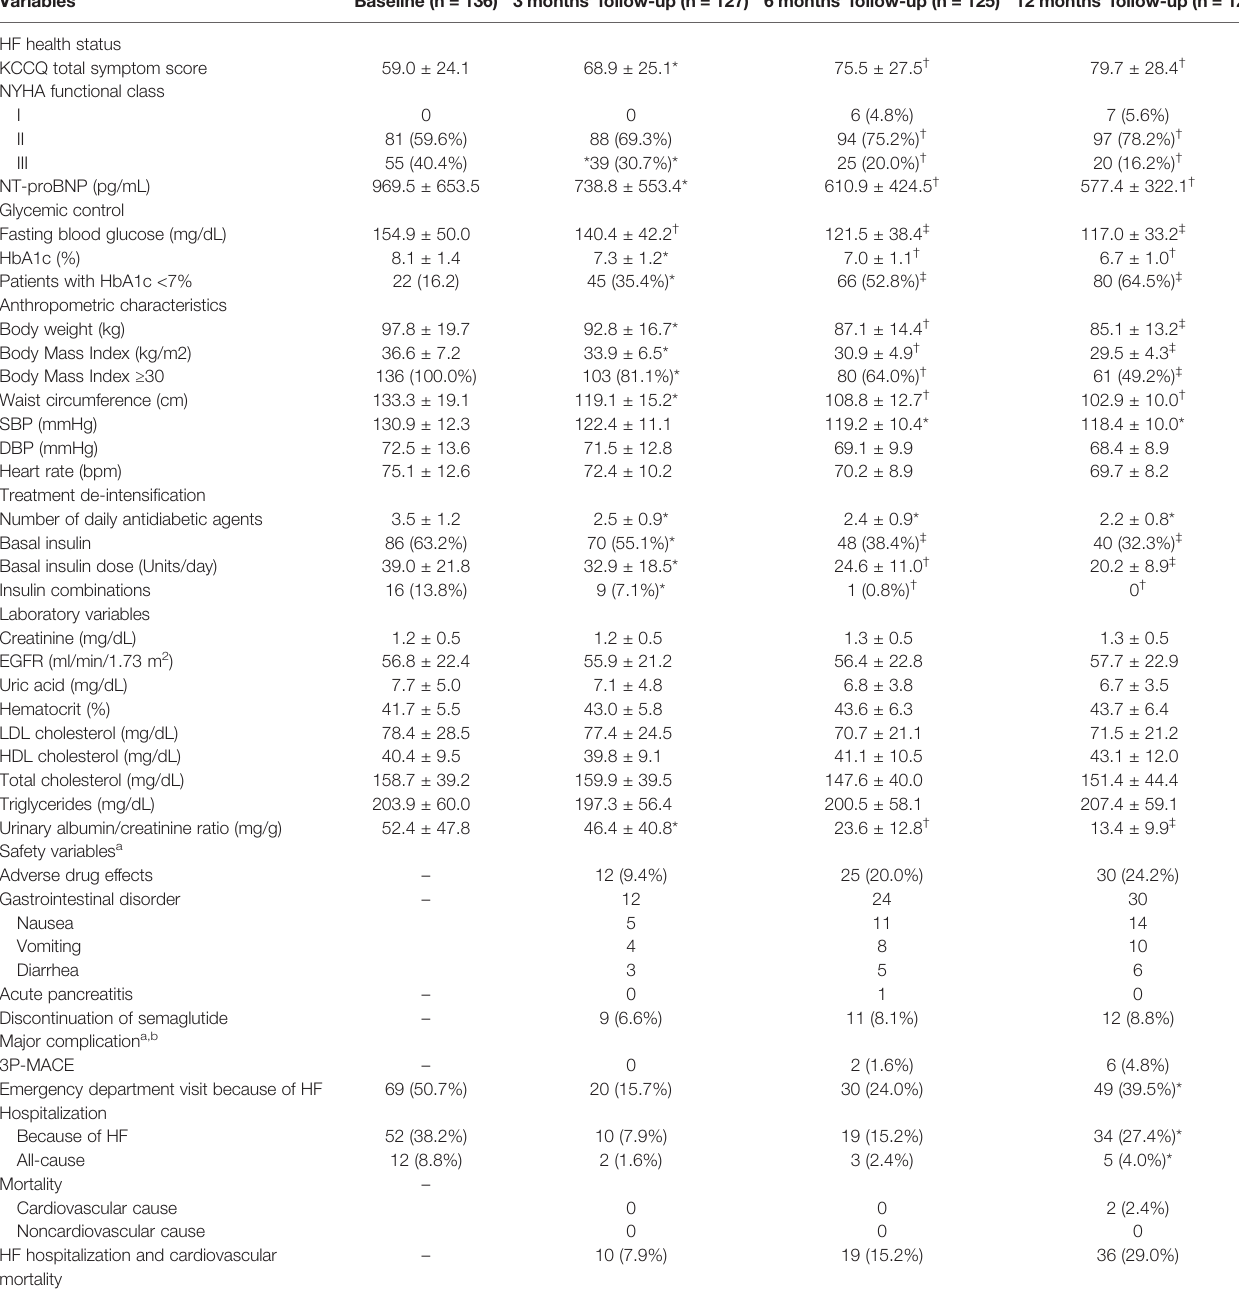
TABLE 2 | Clinical ef fi cacy in the heart failure health status, glycemic control, anthropometric characteristics, treatment de-intensi fi cation, laboratory variables, and safety.